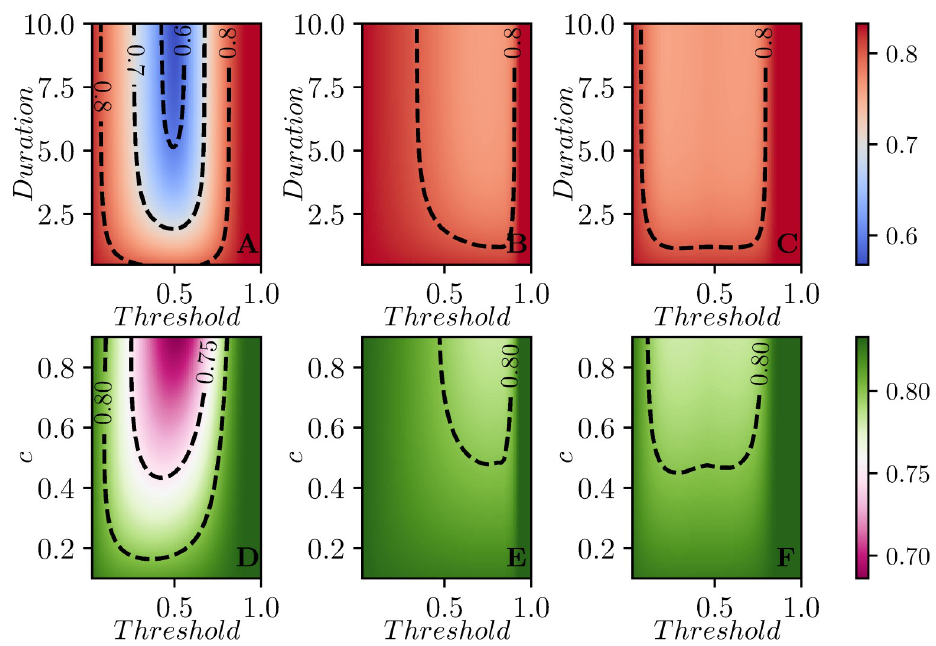
Fig 5. Contour plots showing the average attack rate (final epidemic size) over 100 simulated populations for each set of parameter values. In the first row c is fixed and the duration of control varies on the vertical axis, while in the second row duration is fixed and c varies. Each column corresponds to one of the three strategies: A,D intervention in each subcommunity based on that subcommunity reaching a threshold, B,E global intervention when the first subcommunity breaches the threshold, and C,F global intervention at global threshold for a population consisting of 9 subcommunities. In each plot, the x - axis shows the values that the threshold for intervention can take (from a minimum of 0.05 to a maximum of 0.8). In the first row c = 0.8 is constant, while the duration of control varies from a minimum of T = 1 to a maximum of T = 10. On the second row instead, the duration of control is kept fixed at T = 2, and the values of c varies from c = 0.1 to c = 0.9. The recovery rate is γ = 1 for all subcommunities. In all cases, if the threshold is set too large the intervention is never implemented. The two synchronized interventions can be approximately mapped to one another by noting the largest I i + R i at the time the global I + R reaches a given threshold. The subcommunity threshold gives more resolution at small values while the global threshold gives more resolution at large